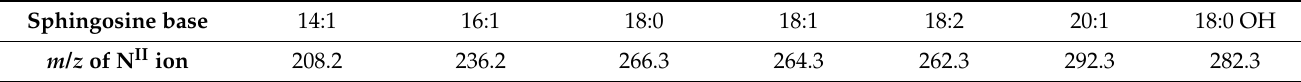
Table 1. Common sphingosine bases and their m/z values for N II fragment in positive ion mode. Sphingosine base m/z of N II ion 208.2 236.2 266.3 264.3 262.3 292.3 282.3 Although MS/MS spectra of Gb 3 and Gb 4 (Figure 5C,D) do not include the N-type fragment ion due to the low mass cut-off, the presence of this ion was further confirmed by performing MS 3 experiment, where the ion at m/z 520.5 was fragmented for both Gb 3 and Gb 4 (Figure S3). The origin of N-type fragment ion (i.e., N II ), along with other low abundant fragment ions (e.g., S, T, and U) sporadically observed in MS/MS spectra, is illustrated in Figure 6.